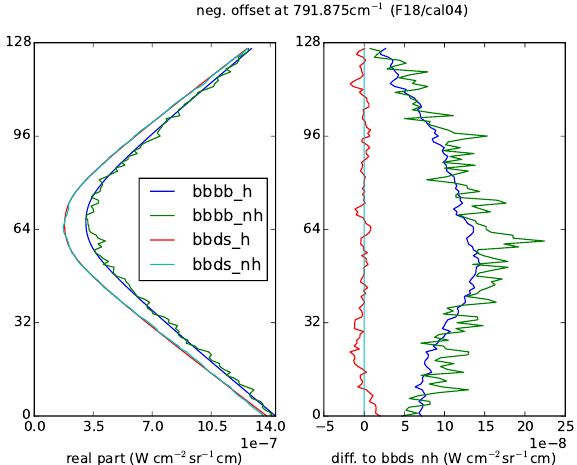
Figure 3. Magnitude of the IG for different calibration methods at 791.875cm − 1 . The panels are laid out the same way as in Fig. 2. The variation from the lower left to the upper right corner is caused by a composition change in the detector material. An offset value given above a plot indicates that all values are to be understood as with this value subtracted.